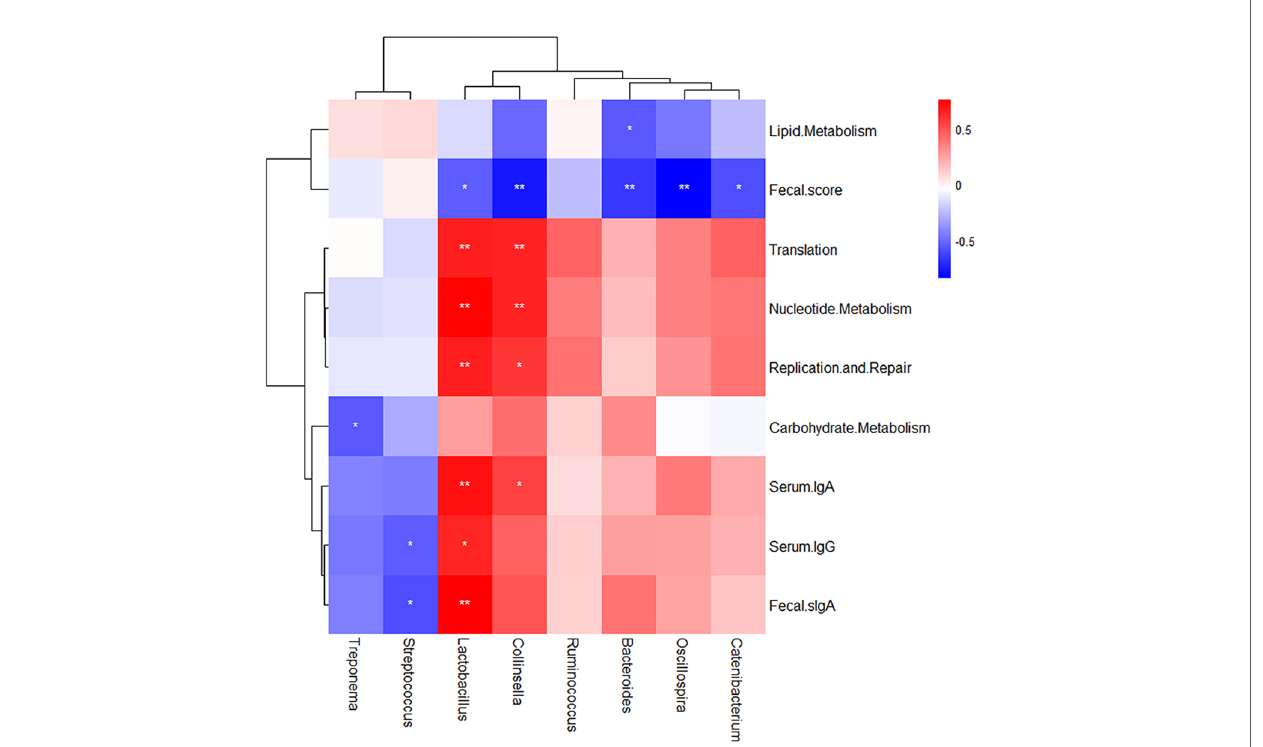
FIGURE 10 | Correlation analysis between intestinal micro fl ora composition changes and body function indexes. The Spearman rank correlation analysis was used and drawn by R software (version 3.6.1) with pheatmap package. The color legend is on the top right of the fi gure. Red indicates positive correlation; blue indicates negative correlation. * p < 0.05 and ** p < 0.01 using Student ’ s t-test to evaluate differences between every two